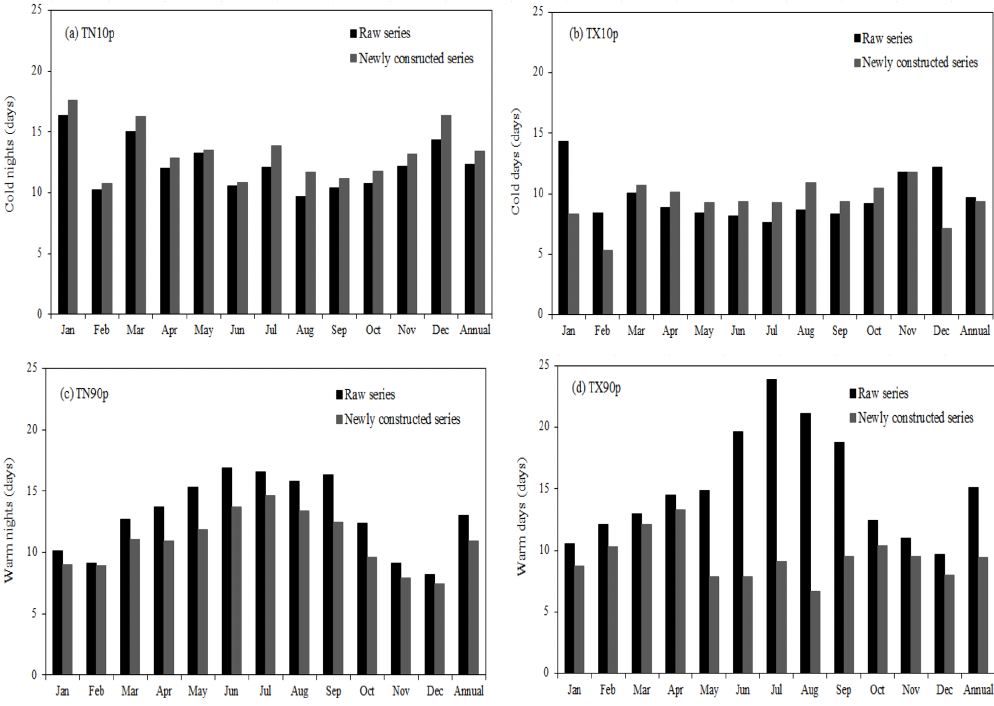
Figure 9. Annual and monthly temperature extremes of cold nights (TN10p) (a) , cold days (TX10p) (b) , warm nights (TN90p) (c) and warm days (TX90p) (d) for daily newly constructed and raw temperatures (after quality control and extension) in Tianjin. Table 6. Comparisons between newly constructed surface air temperatures and previous assessments of the annual trend change at the century-long scale in Tianjin with uncertainties at the 95% significance level (unit – ◦ C per decade). Newly constructed CRU TS4.03